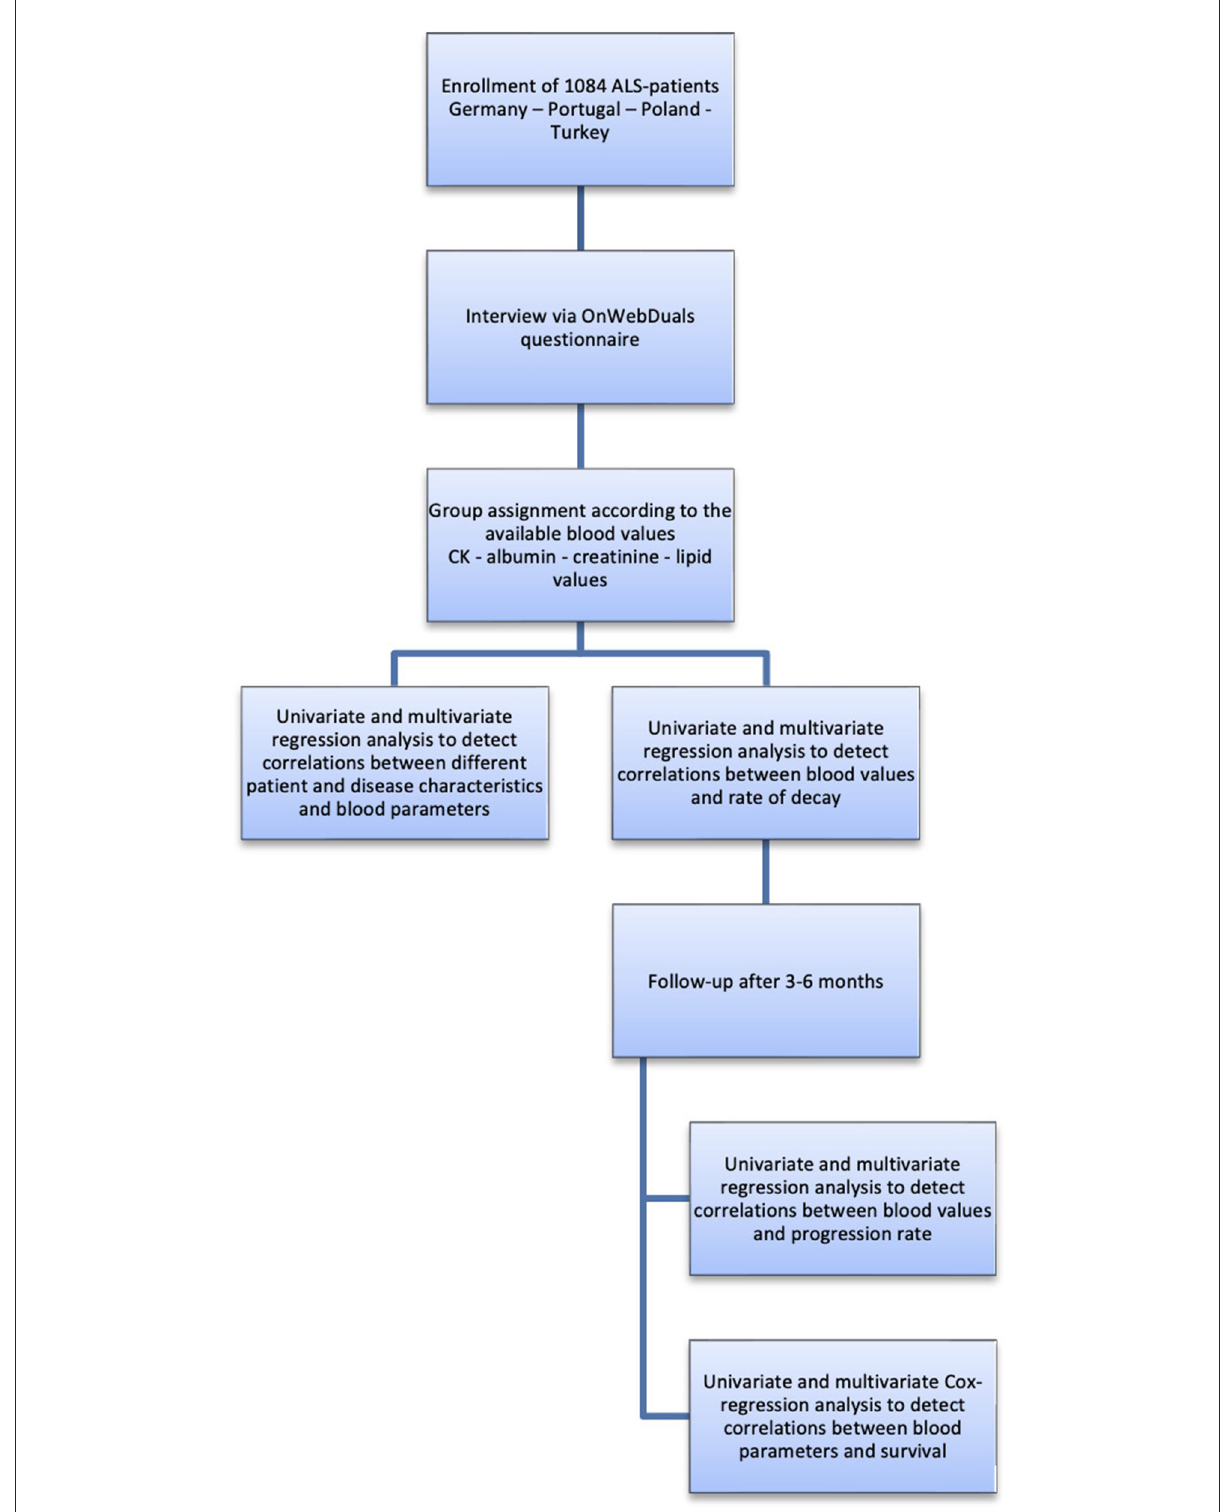
FIGURE1 Research flow